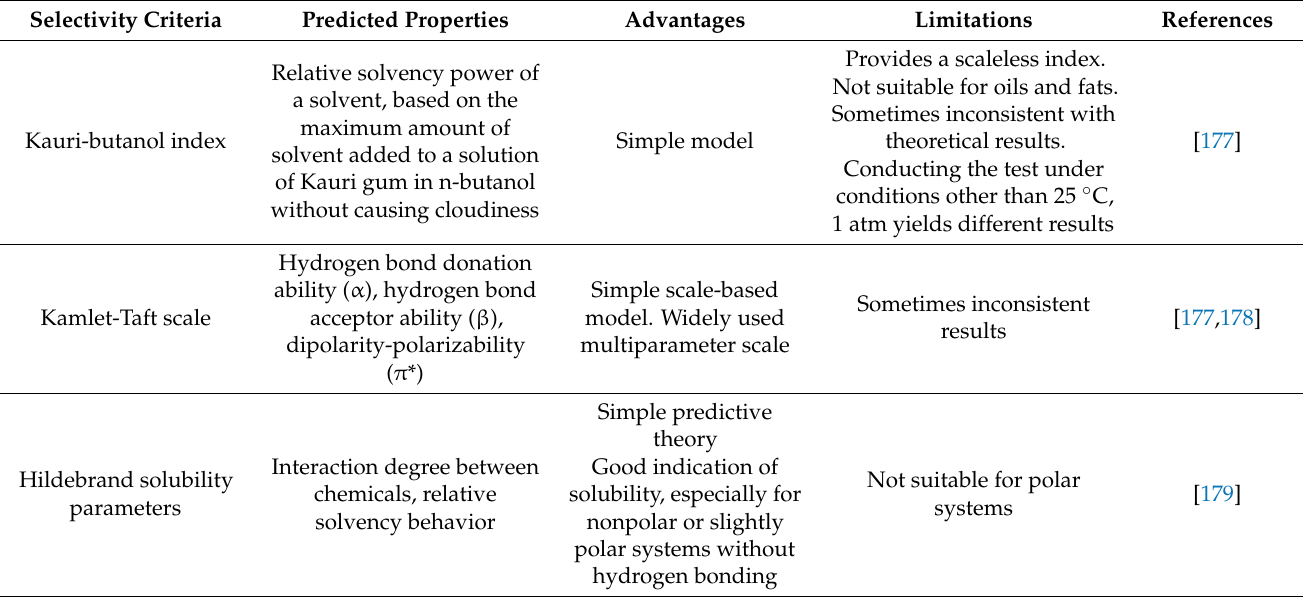
Table 5. Computational models, predicted physical properties, and their associated advantages and